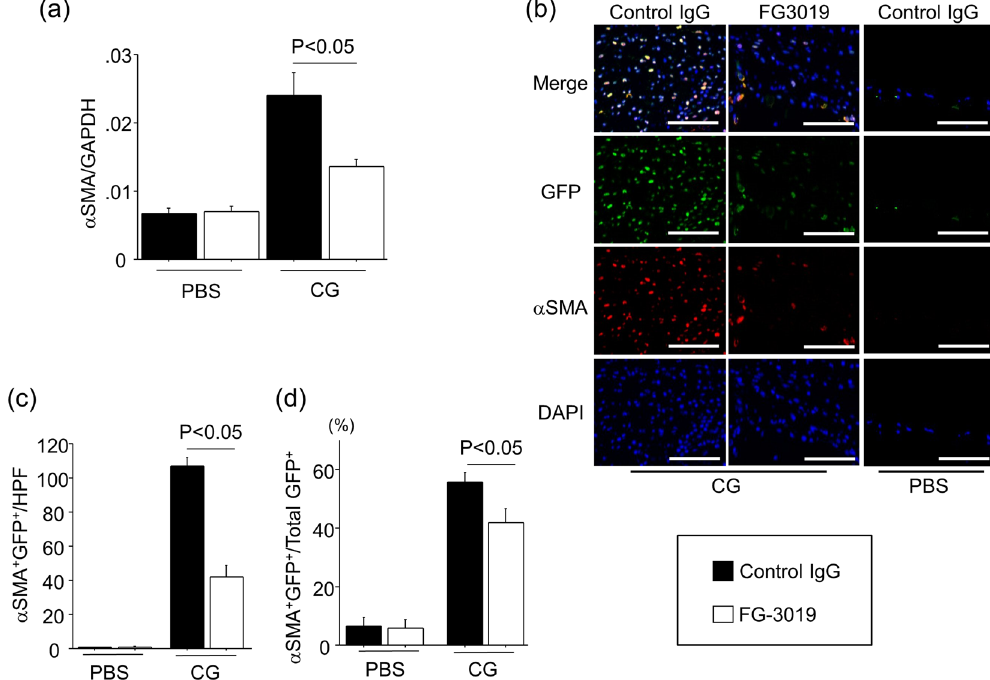
Figure 3. The accumulation of peritoneal α SMA + myofibroblasts is mediated by CTGF in peritoneal fibrosis induced by CG. ( a ) Peritoneal expression of α SMA mRNA (n = 5 mice/each group). Data are expressed as mean copies of α SMA mRNA relative to copies of GAPDH mRNA ± SEM. ( b ) Accumulation of peritoneal myofibroblasts ( α SMA + GFP + ). Peritoneal sections at day 21 were obtained from mice treated with control IgG or FG-3019. Representative tissue sections stained with anti- α SMA antibody (red)/anti-GFP antibody (green) are shown. Bars, 50 μ m. ( c ) Numbers of α SMA + GFP + cells in the peritoneum are expressed as the mean number ± SEM per HPF (n = 5 mice/group). ( d ) Percentages of peritoneal myofibroblasts among total fibroblasts ( α SMA + GFP + cells/total GFP +